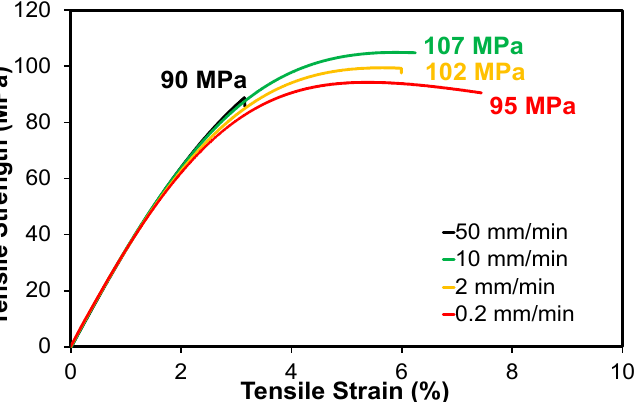
Figure 10. Representative stress–strain curves for the modified system (MEP) with different stain rates.